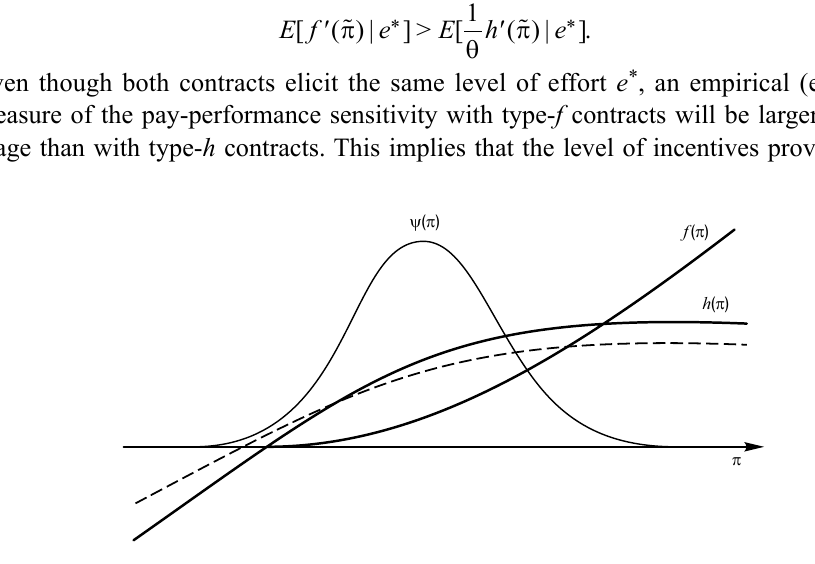
Fig. 1. Managerial compensation as a function of the measure of performance p Notes: The convex contract f is given. The concave contract h is the transformation of the convex contract f with the same average slope and the same variance described in the Proof of Proposition 1. The concave contract with a dotted line is the flattened version of the concave contract h which induces the same level of effort as the initial convex